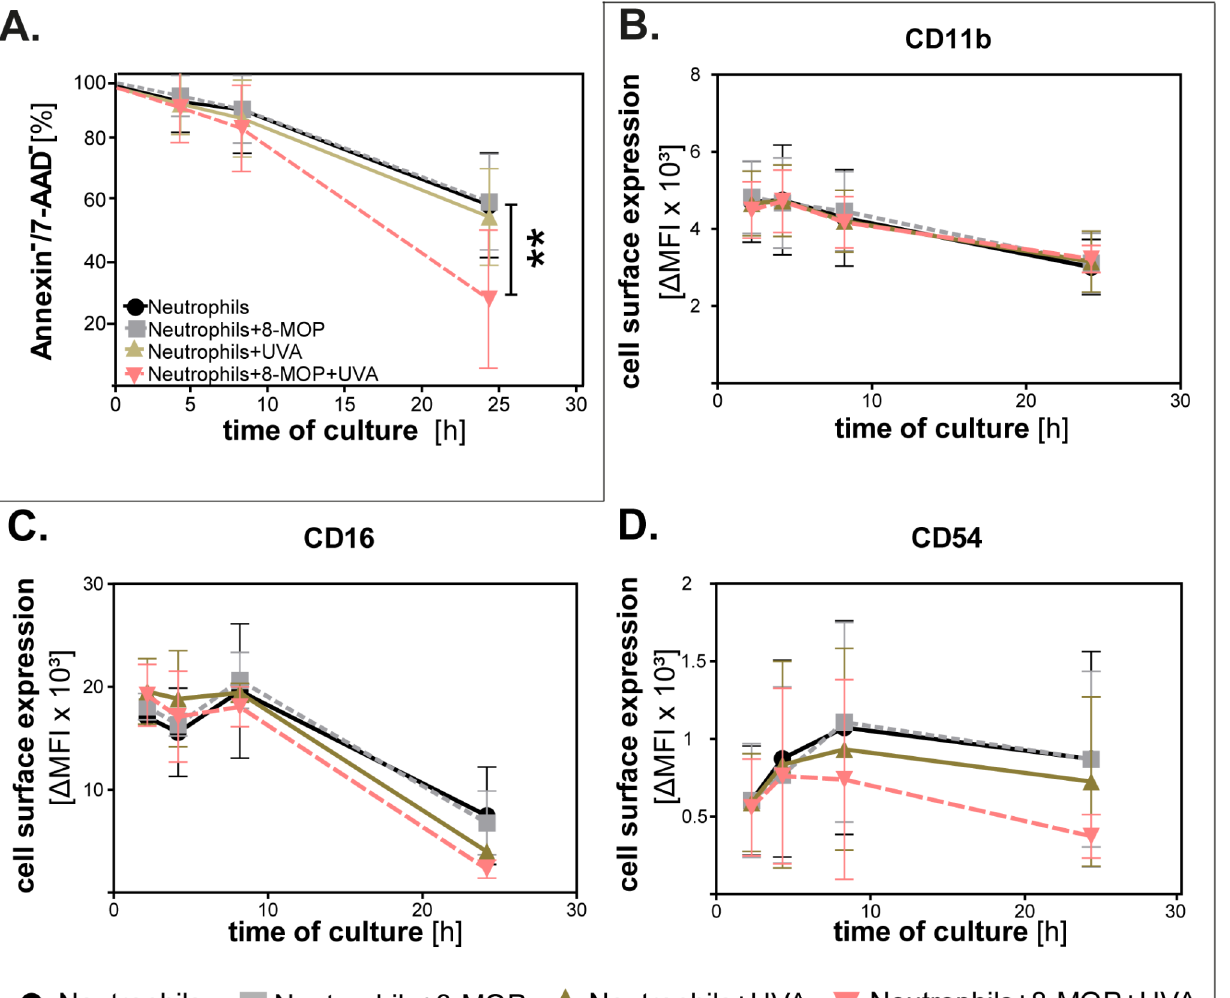
Fig 2. (A) In vitro treatment of healthy donor neutrophils with 8-methoxypsoralen and UVA induces apoptosis and decreases activation markers. Neutrophils, isolated from blood of healthy donors, were treated with 8-MOP and UVA light and cultured for 24h. Control groups were untreated neutrophils, neutrophils treated with 8-MOP and neutrophils treated with UVA light. Percentage of non-apoptotic cells was determined by the % of Annexin V and 7-AAD double-negative cells via flow cytometry 0, 4, 8 and 24h after irradiation (n = 4). Curves show mean ± standard deviation (SD). ** p (cid:3) 0.01. (B-D) Viable (= Annexin - / 7-AAD - ) neutrophils of the same groups (n = 4) were stained for activation markers CD11b, CD16 and CD54 at 2, 4, 8 and 24h after irradiation and protein expression was measured by flow cytometry after gating on viable cells. Curves show mean of Δ median of MFI ± SD. MFI = mean fluorescence intensity, Δ median of MFI = MFI of antibody-MFI of isotype